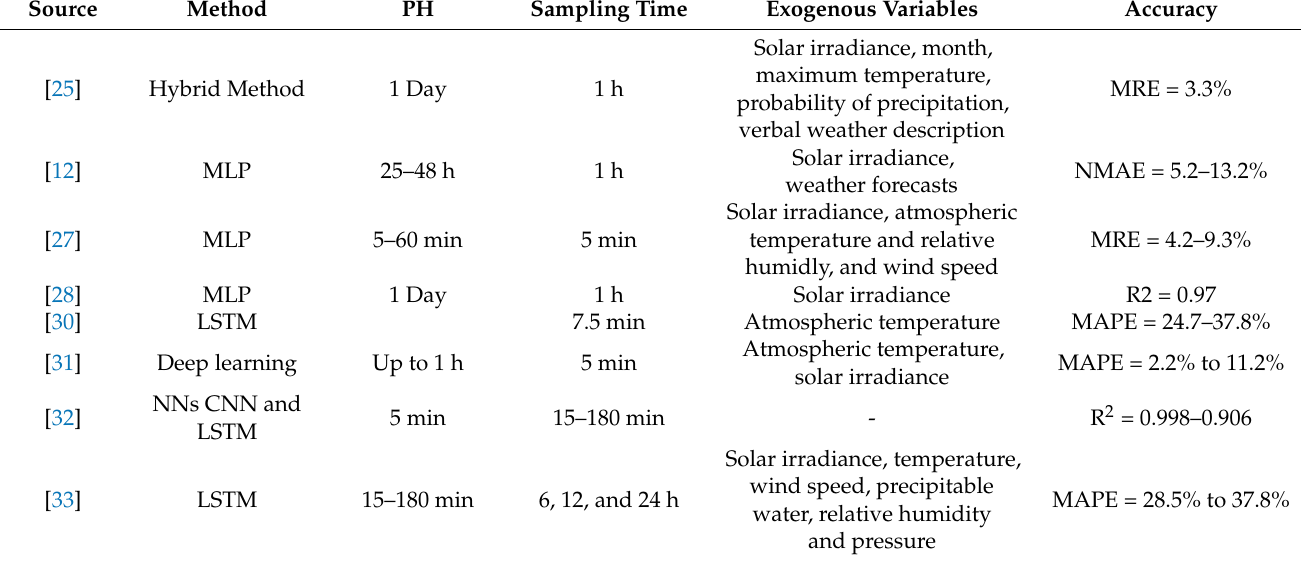
Table 1. Related